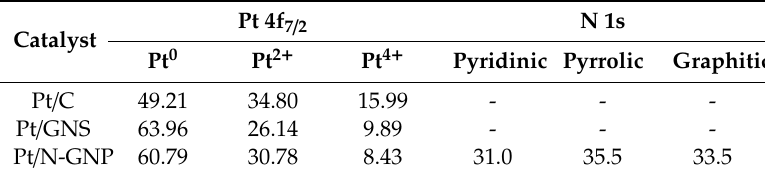
Table 1. The number averaged particle size (d n ) have been calculated using Equation